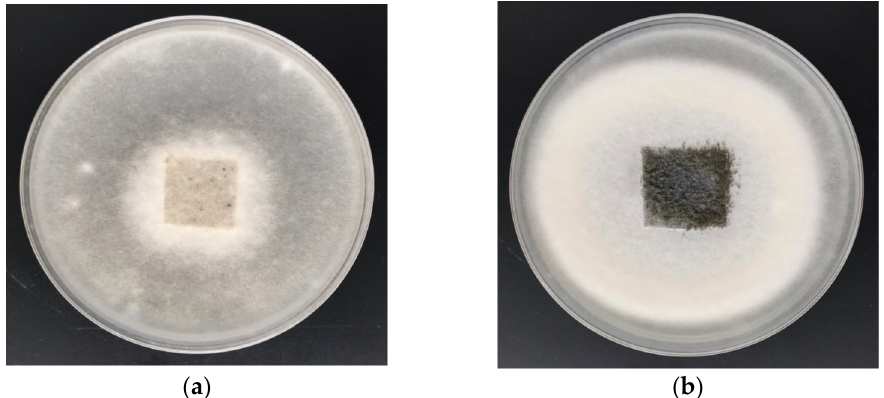
Figure 8. Antimicrobial activity tests against C. globosum. Inhibition properties of fungal growth in Petri dishes: ( a ) COT; ( b ) COT–Zn-10 (1 s/2 s). Table 6. Results of the antifungal activity test and growth inhibition effects of zinc compounds and composites.